Question: What form of chart is displayed?
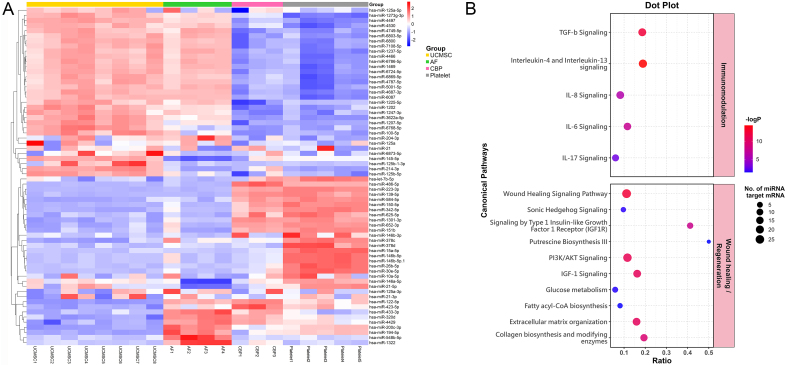
Answer: heatmap